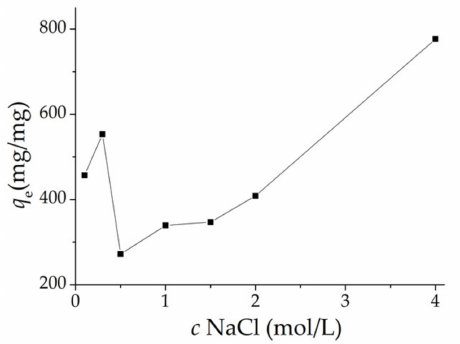
Figure 5. E ff ect of ionic strength on the adsorption of Cr 6 + onto the CHGE − H